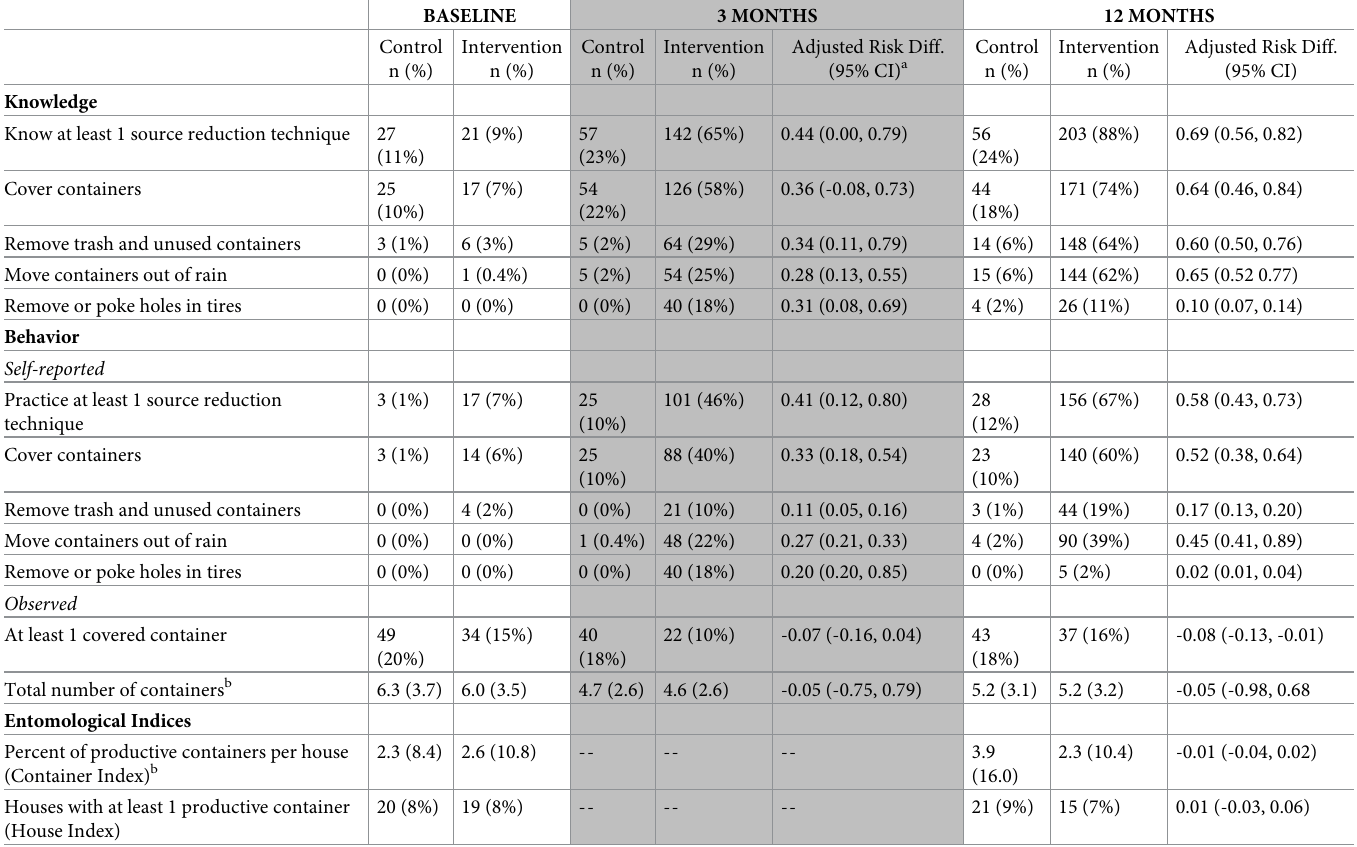
Table 2. Knowledge, behavior, and entomological indices at baseline and after 3 and 12